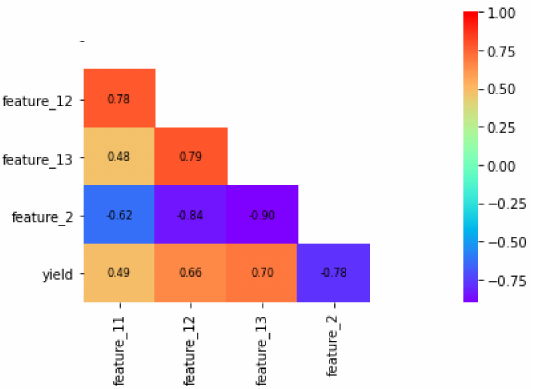
Figure 9. Correlation analysis heat map between the extracted features of LSTM and yield.